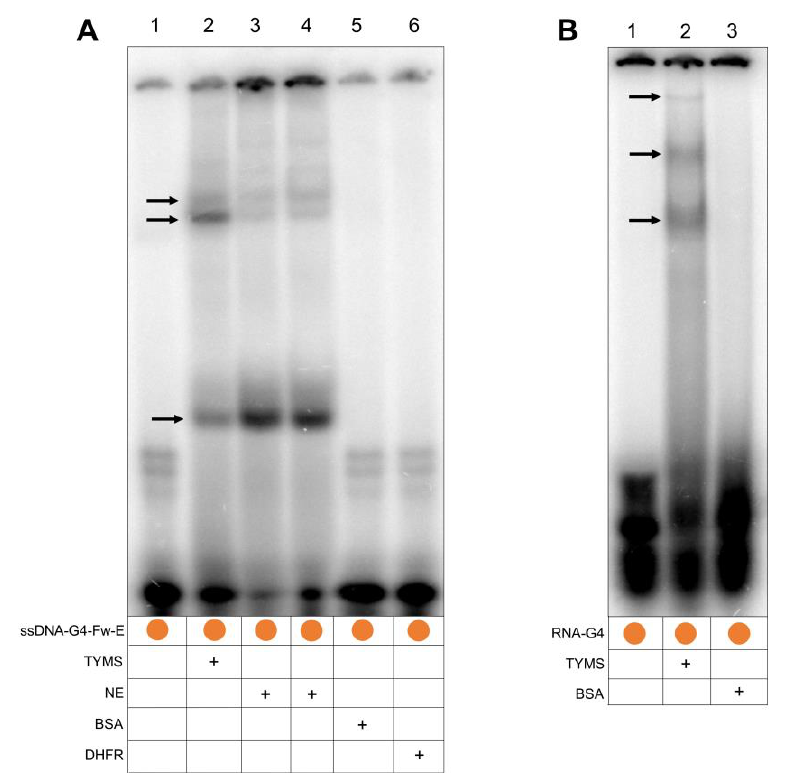
Figure 3. Binding of TYMS protein to the G4FS mRNA. EMSAs using 32 P-radiolabeled ssDNA ( A ) or RNA ( B ) probes corresponding to the G4FS. ( A ) Lane 1, ssDNA-G4-Fw-E probe alone; lane 2, ssDNA-G4-Fw-E plus TYMS protein (1.5 µ g); lane 3 and 4, ssDNA-G4-Fw-E plus nuclear protein extract (2 µ g) in duplicate; lane 5, ssDNA-G4-Fw-E plus BSA protein (2 µ g); lane 6, ssDNA-G4-Fw-E plus DHFR protein (2 µ g). ( B ) Lane 1, RNA-G4 probe alone; lane 2, RNA-G4 plus TYMS protein (1.5 µ g); lane 3, RNA-G4 plus BSA protein (2 µ g). Arrows indicate the shifted bands corresponding to the di ff erent molecular